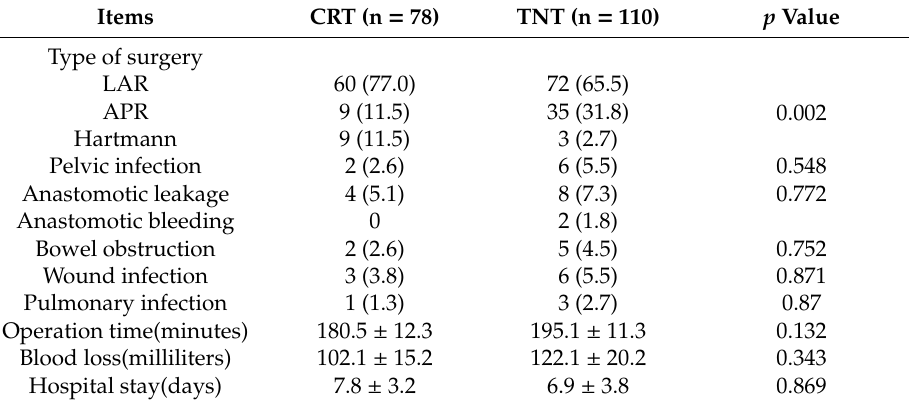
Table 4. Surgical